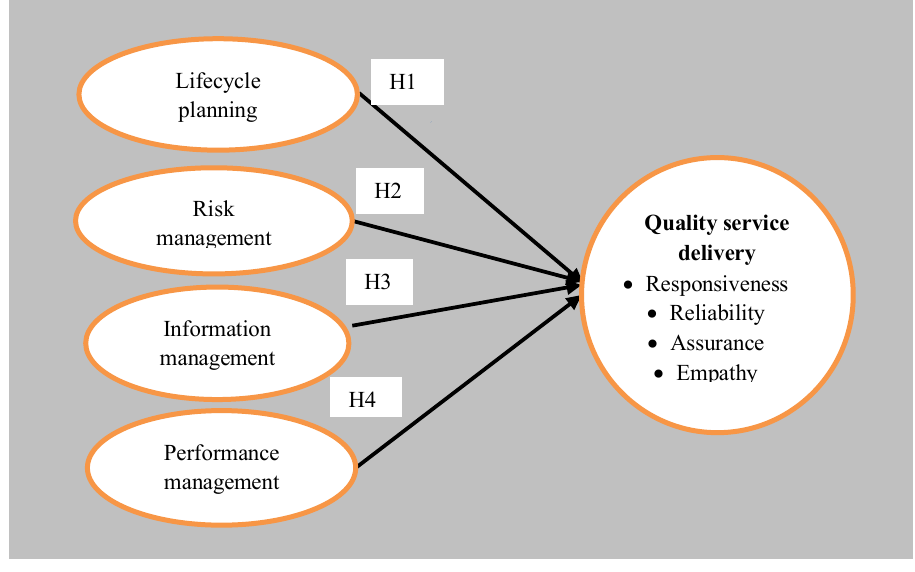
Figure 1: The proposed model